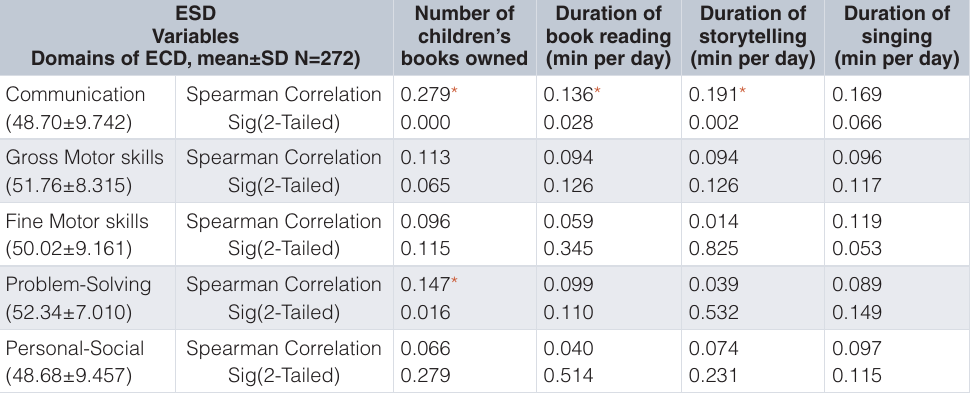
Table 3. Correlation between Early Storybook Reading (ESD) and Early Childhood Development